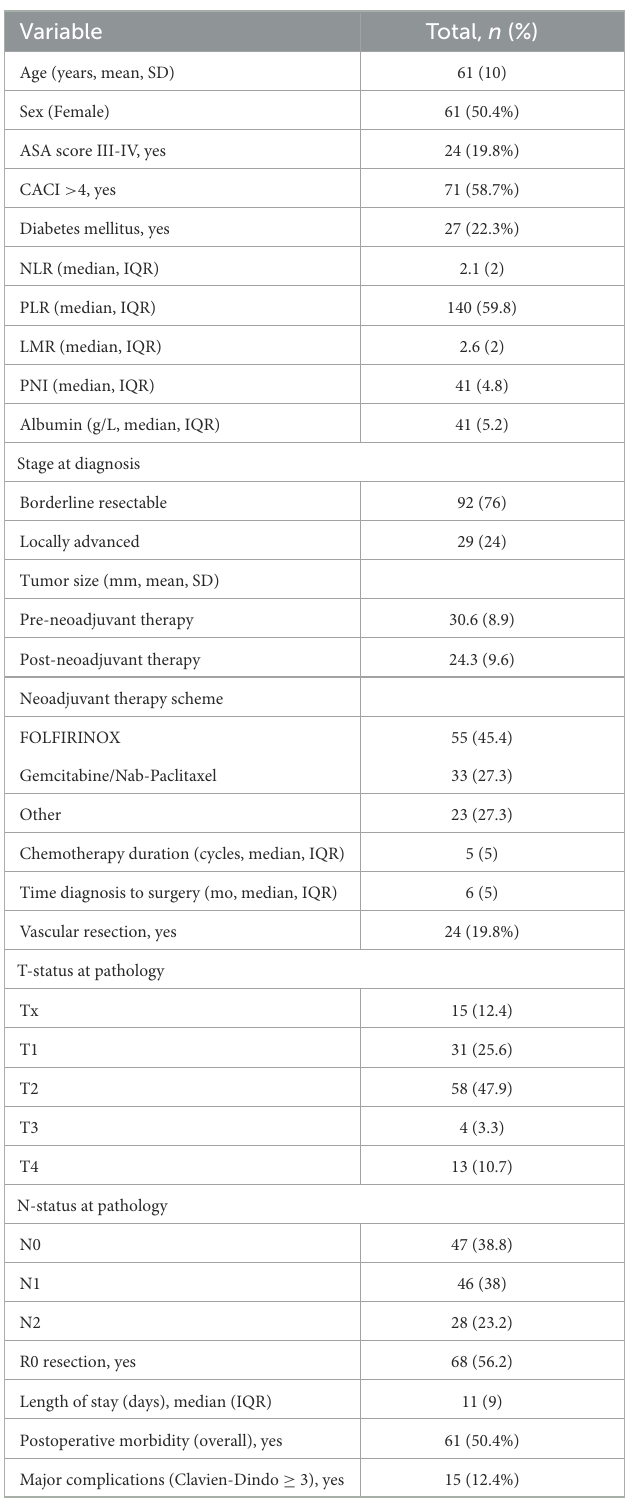
TABLE 1 Study population’s general characteristics ( n =